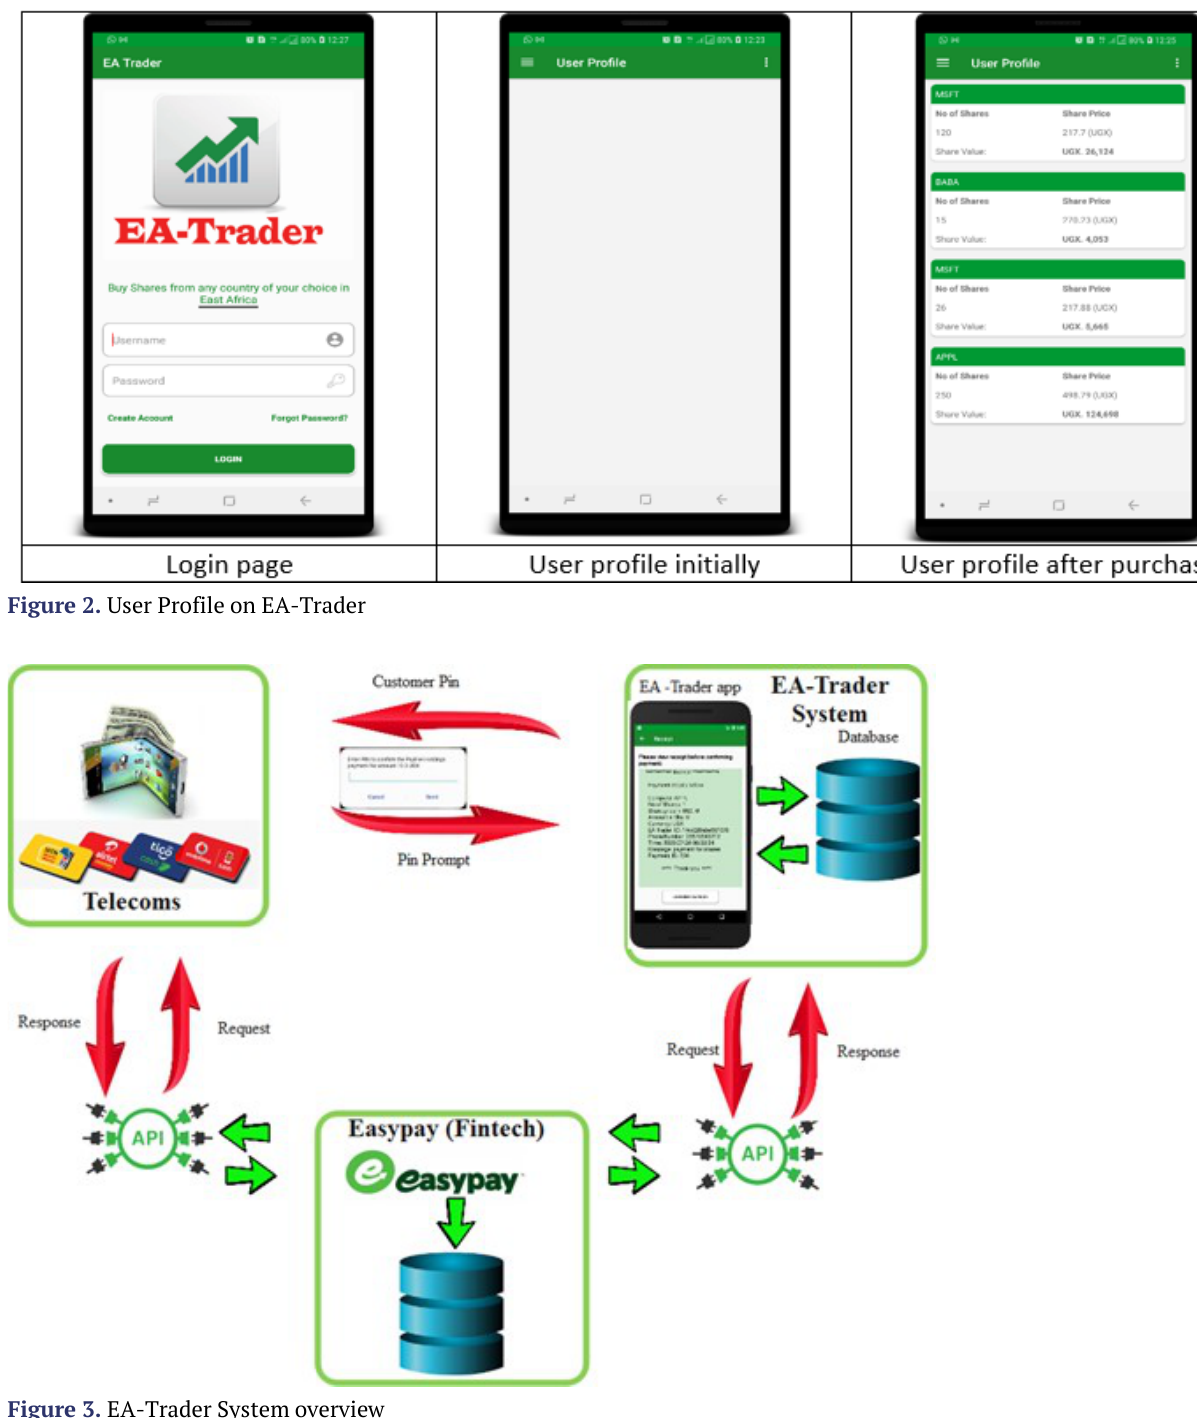
Figure 3. EA-Trader System overview